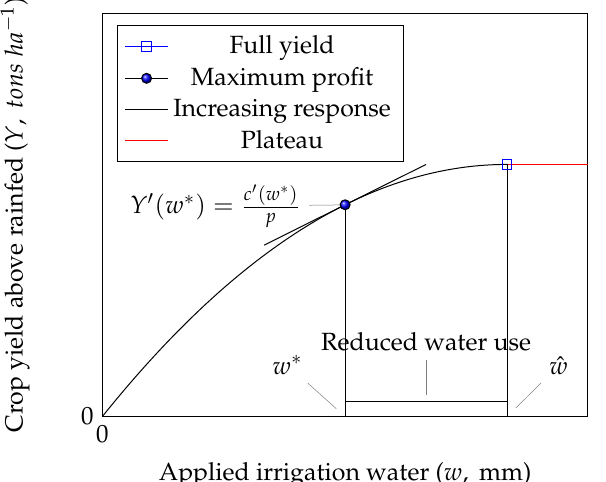
Figure 4. Illustration of the relationship among crop yield, applied irrigation water, and